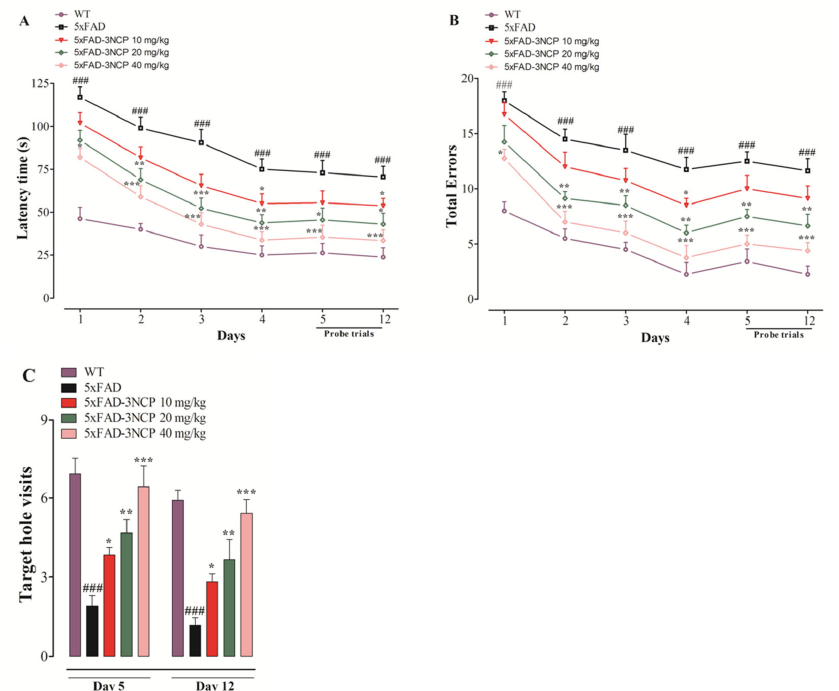
Figure 5. The latency time to search target hole ( A ), and total errors ( B ) of 3NCP treated mice during training and probe trials, and the target hole visits ( C ) during the probe trials in the Barnes maze test. Bars express mean ± SEM. * p < 0.05, ** p < 0.01, *** p < 0.001 compared to the 5xFAD mice, ### p < 0.001 compared to the non-transgenic WT mice. Data were analyzed through two-way